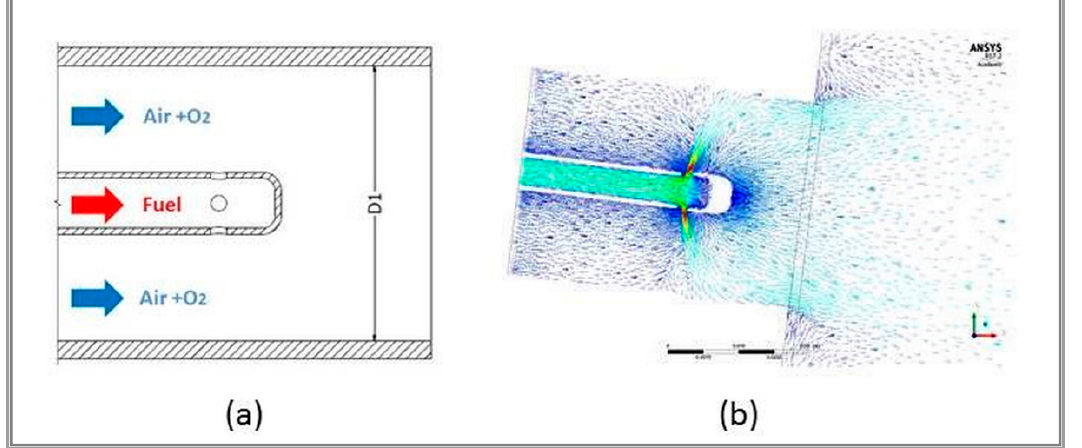
Figure 3. ( a ) Schematic presentation of the gas and oxidizer flow; ( b ) Formation of the combustion mixture.